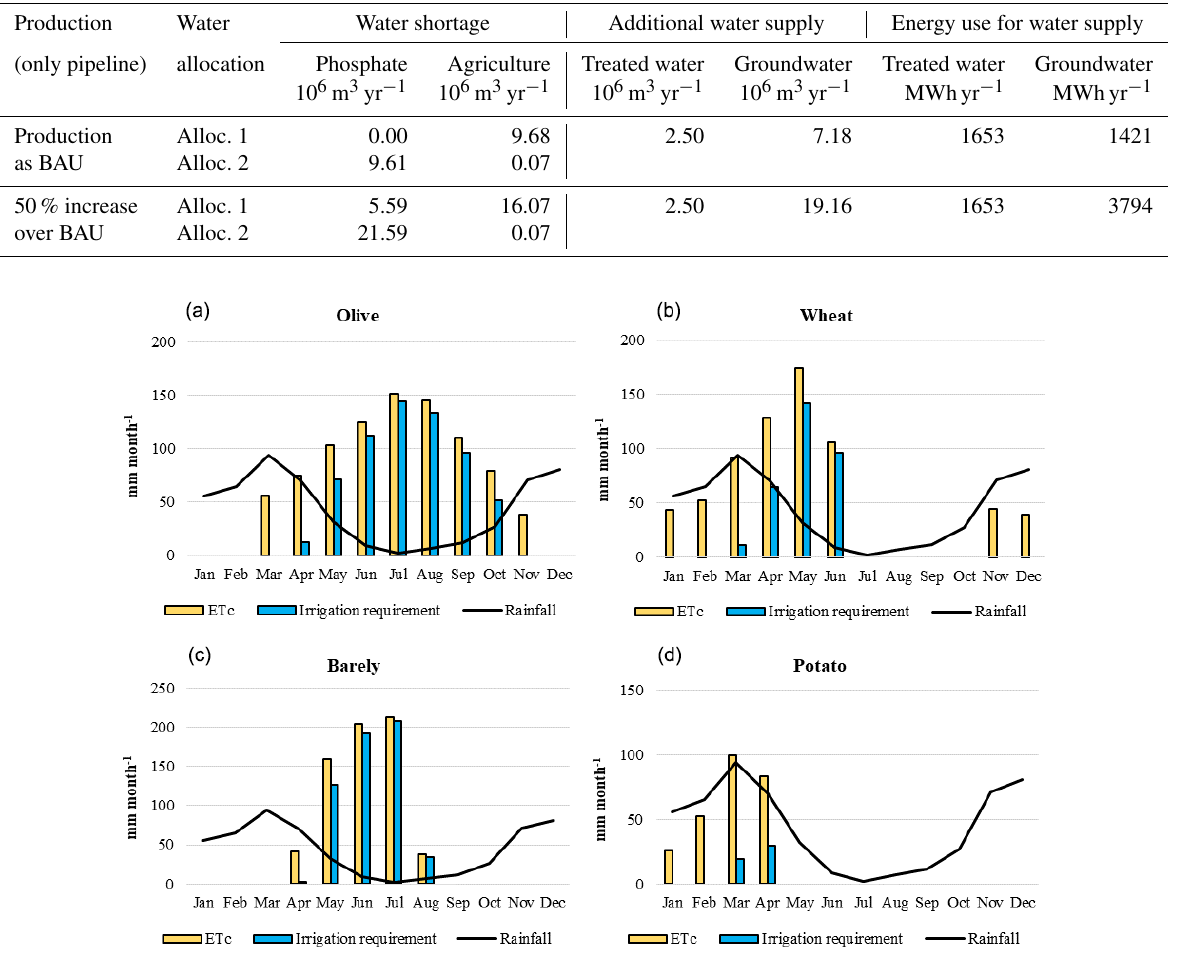
Figure 5. Monthly irrigation water requirement and rainfall in